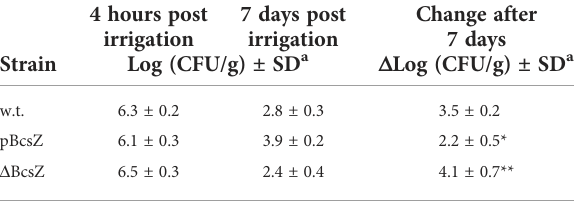
TABLE 1 Survival of S . Typhimurium on parsley